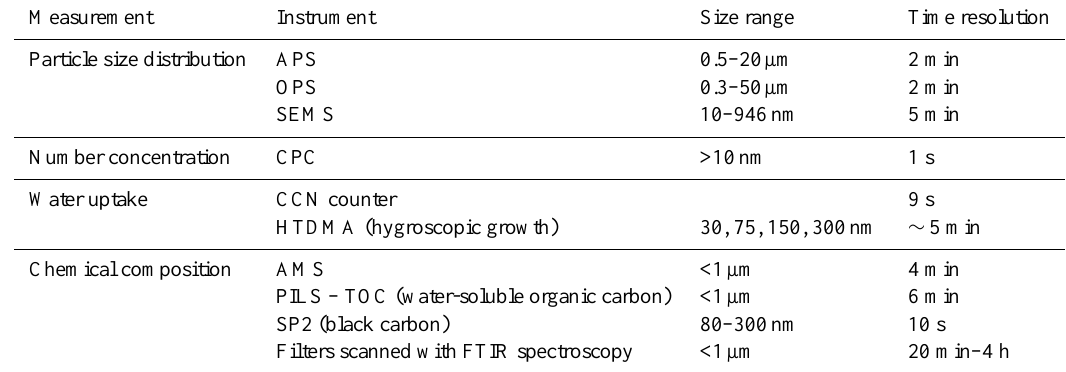
Table 1. Instruments on the R/V Point